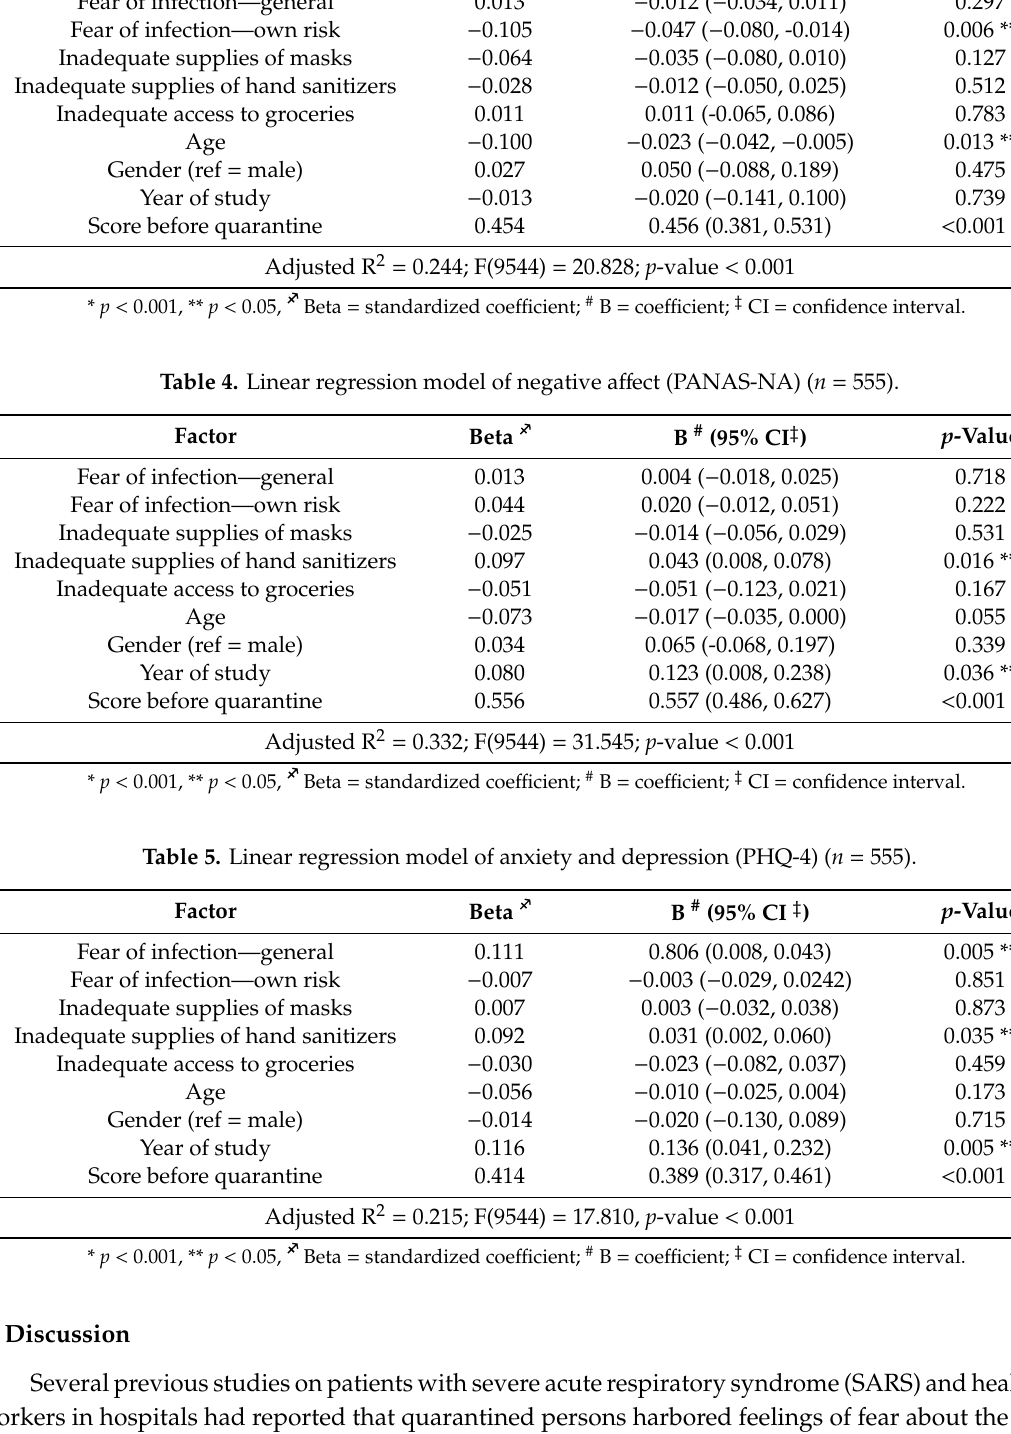
Table 3. Linear regression model of positive a ff ect (PANAS-PA) ( n = 555). Factor Beta Fear of infection—general